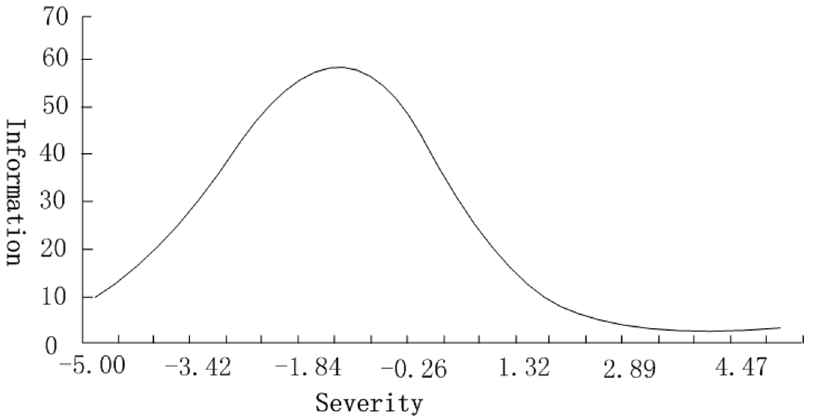
Figure 2. Test information of ASRS. The test information curve of the ASRS based on the bifactor analysis for the general stress factor. X-axis represents severity of the general factor (severity), which had been standardized (0 being average, 1 being a standard deviation). The Y-axis represents the test information value. Test information is a type of reliability criterion in IRT models, the larger the test information value, the less the measurement error and the better the reliability. In contrast to models constructed using CTT, in IRT models, there is a test information value corresponding to every severity point, representing the reliability at that level of severity. We obtained the test information curve by connecting all these values.